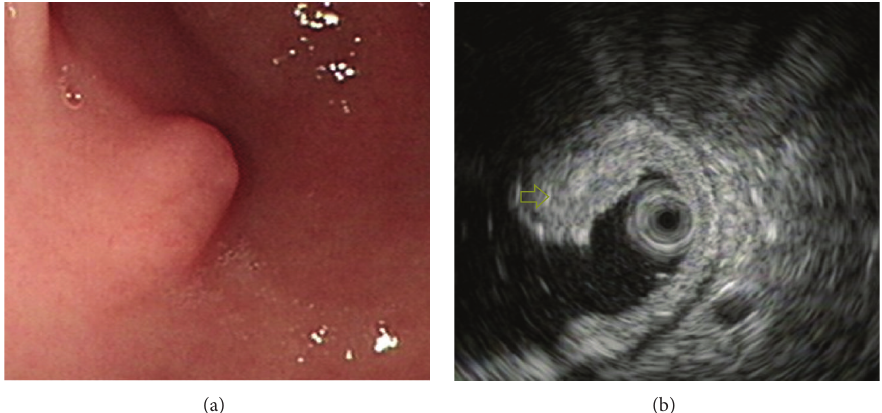
Figure 1: Ectopic pancreas originates from the second and third sonographic layers of the gastric wall. (a) A subepithelial tumor with intact but uneven surface was identified in the antrum. (b) Endoscopic ultrasonographic image obtained with a 12MHz catheter probe. The tumor exhibits heterogeneous, mixed echoic echogenicity and indistinct margins, involving the second and third sonographic layers of the gastric wall (arrow).